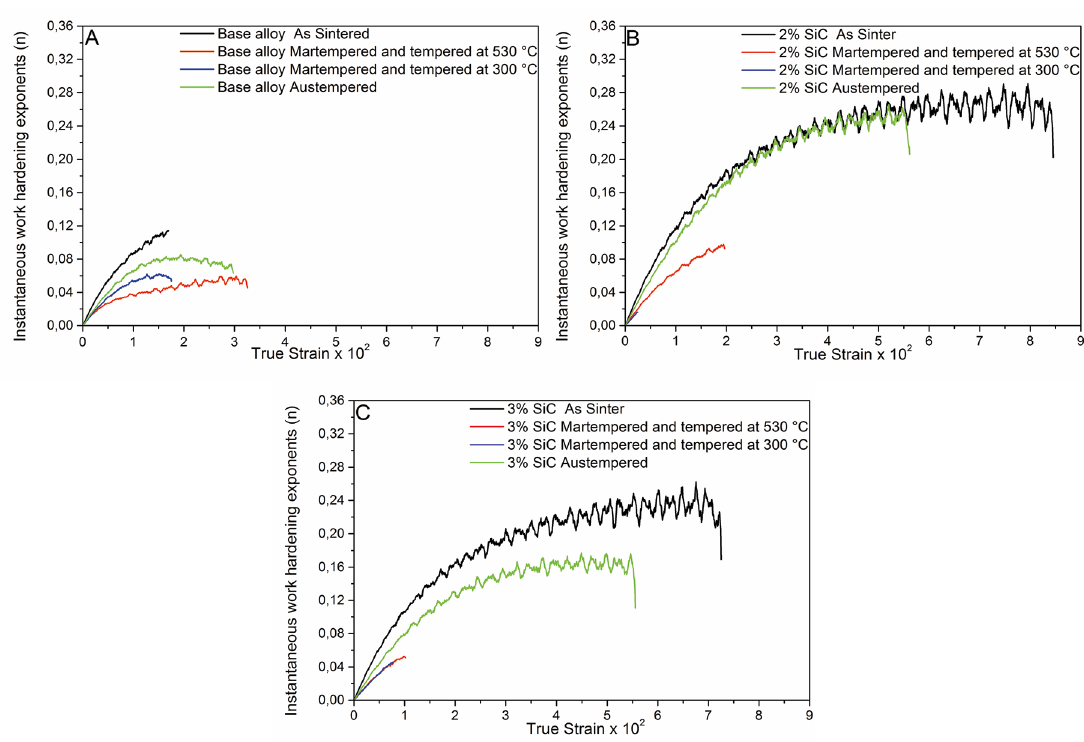
SiC and (C) Base alloy wt